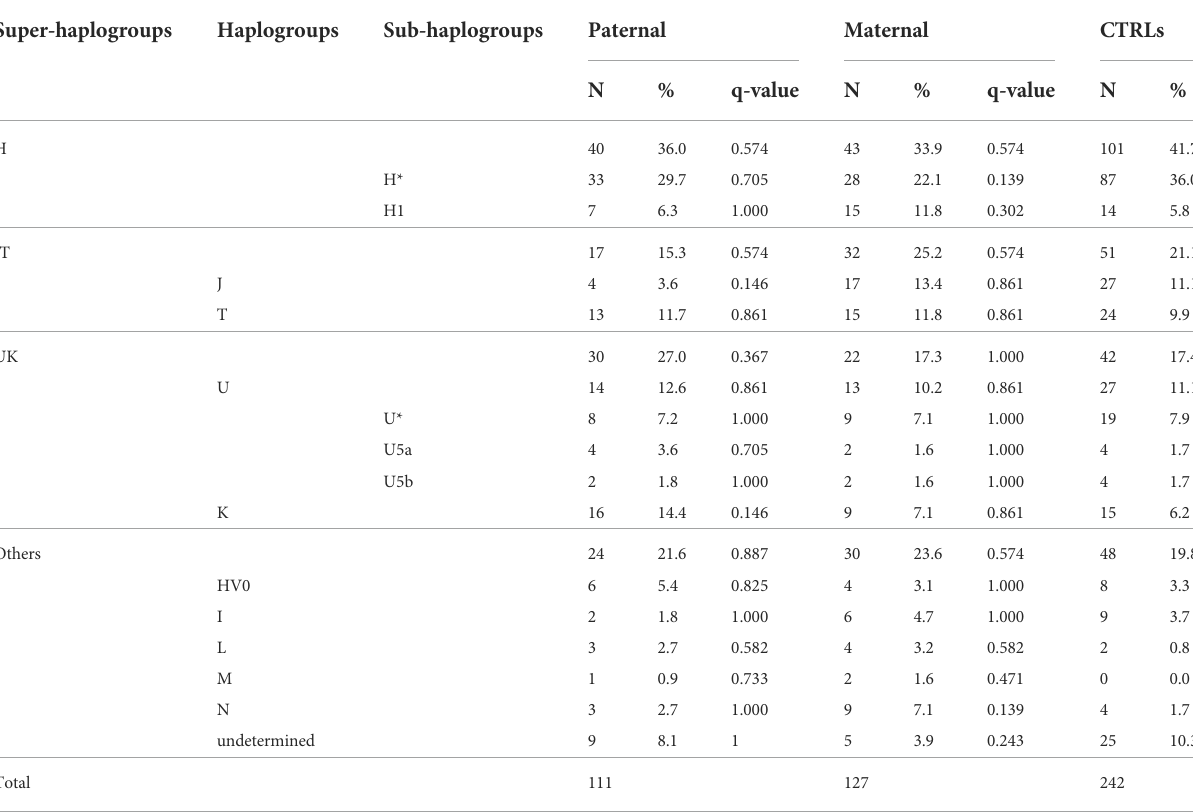
TABLE 2 Mitochondrial haplogroups distribution in Italian ASD paternal and maternal lines from an independent cohort, compared to Italian healthy controls. Super-haplogroups Haplogroups Sub-haplogroups Paternal